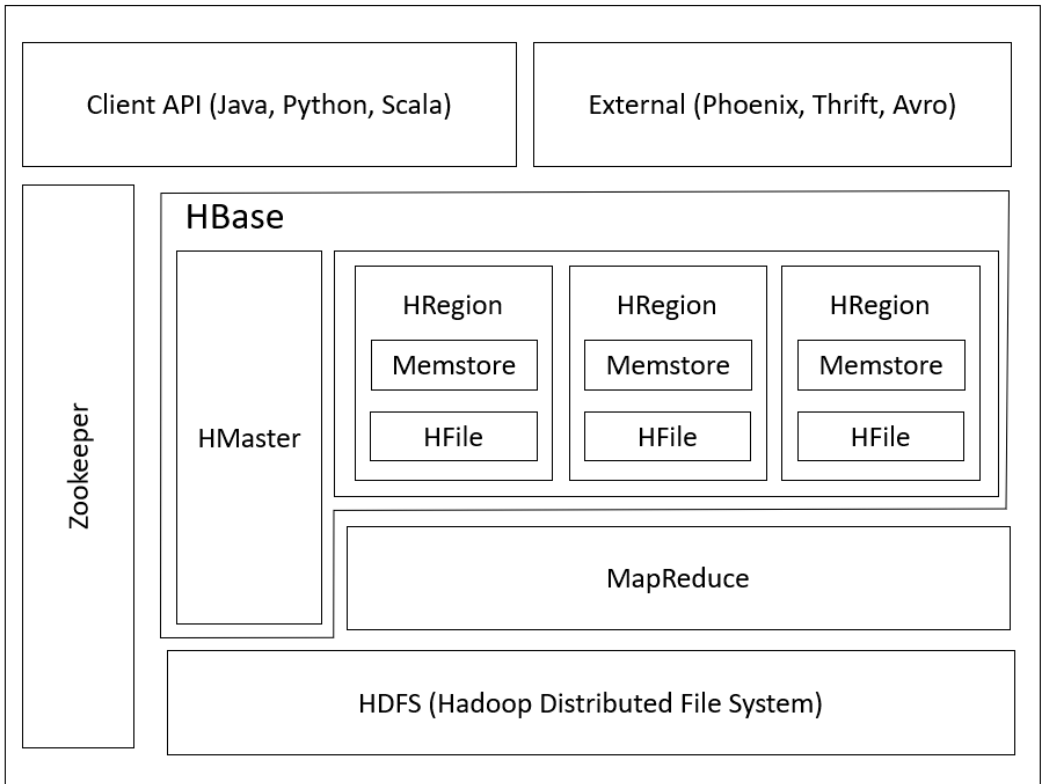
Figure 3. Design Hadoop